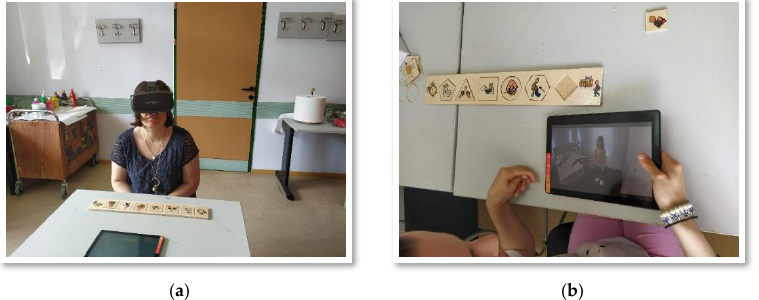
Figure 33. Individual evaluation: ( a ) student with moderate intellectual disability; ( b ) student with cerebral palsy and severe intellectual disability.